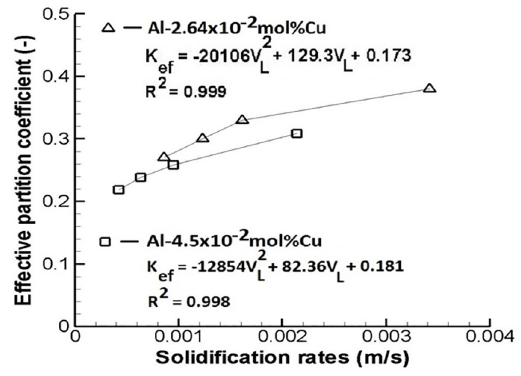
) versus solidification ef